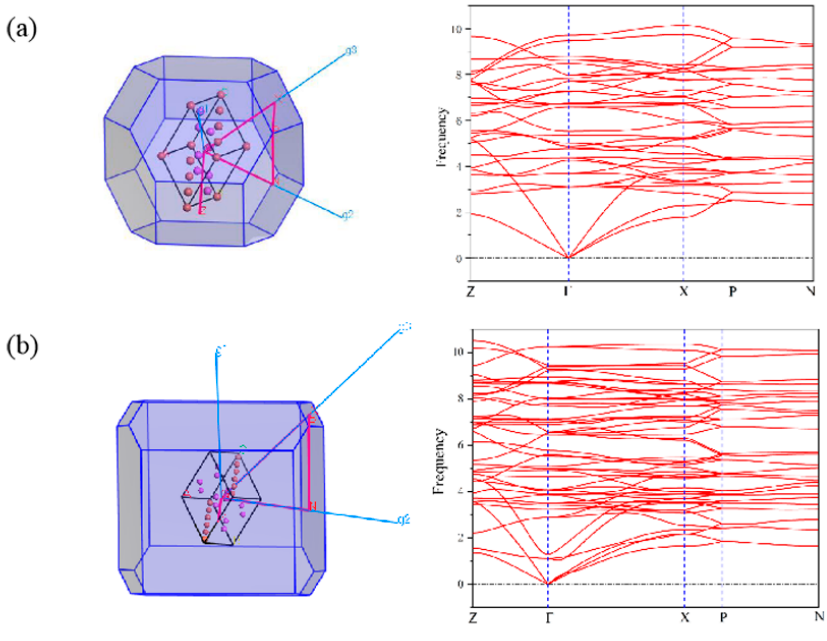
Figure 5. Brillouin zone diagram and phonon spectrum of ( a ) the M1 phase and ( b ) the M2 phase.